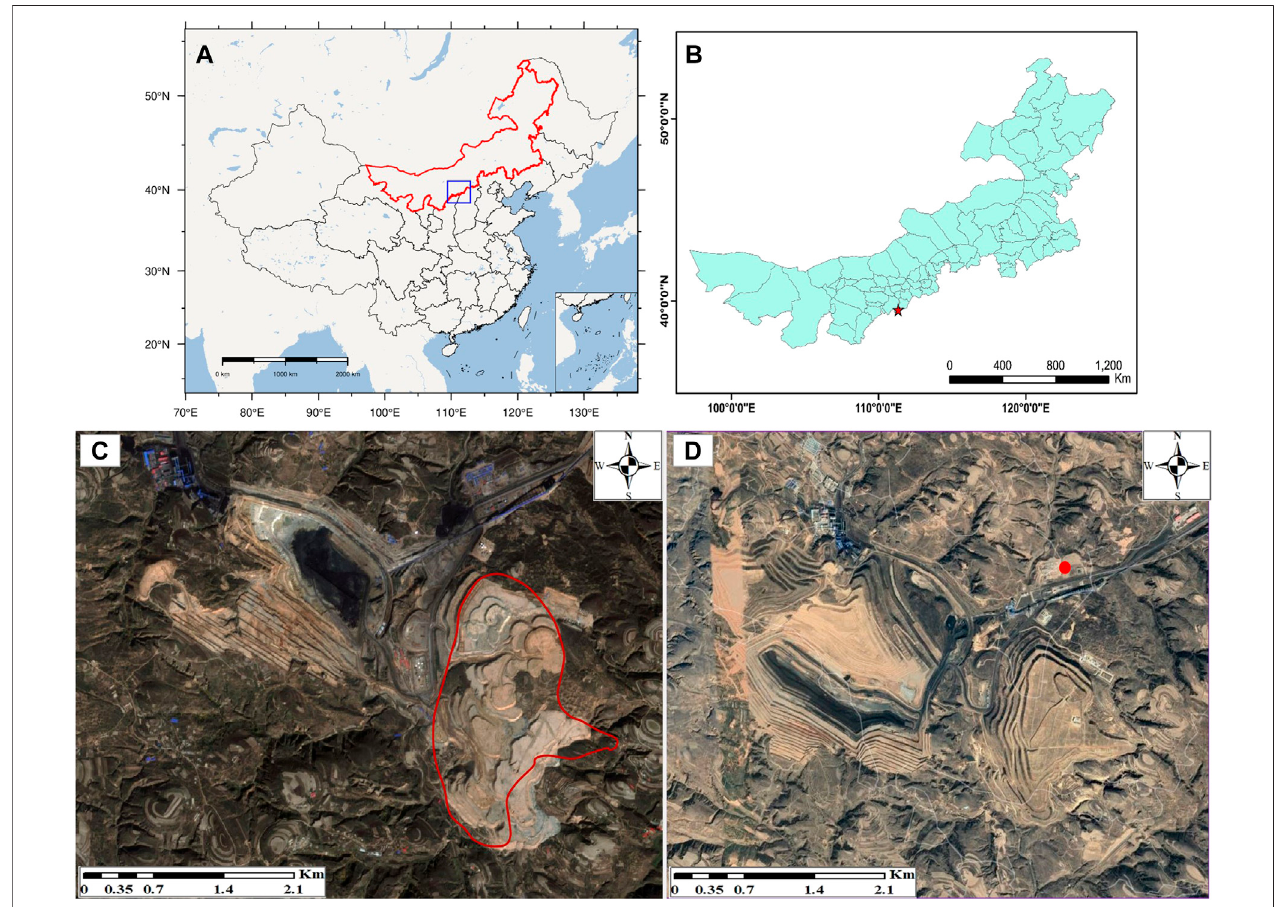
FIGURE1|(A,B) Locationofthestudyarea; (C,D) areopticalimagesofthefocusedminewastedumpintheyearsof2012and2019,respectively.Theredcirclein (D) represents the location of the selected reference pixel for InSAR processing.